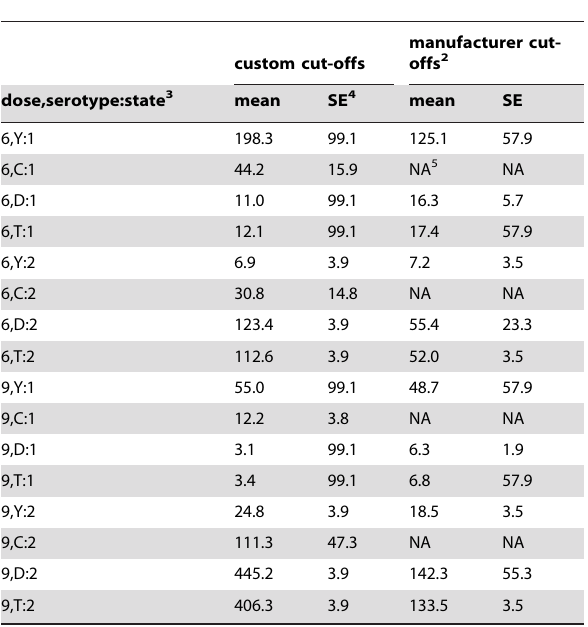
1 Reference groups: low dose and S. Yoruba. 2 Manufacturer cut-offs used for all serotypes except for S. Yoruba. 3 Notation 6, 9, C, Y, D, T, 1 and 2 denote the low dose, high dose, S. Cubana, S. Yoruba, S. Derby and S. Typhimurium, below seroconversion level state and above seroconversion level state, respectively. 4 SE standard errors of the mean sojourn times. 5 NA=not estimated. doi:10.1371/journal.pone.0034660.t003 PLoS ONE |